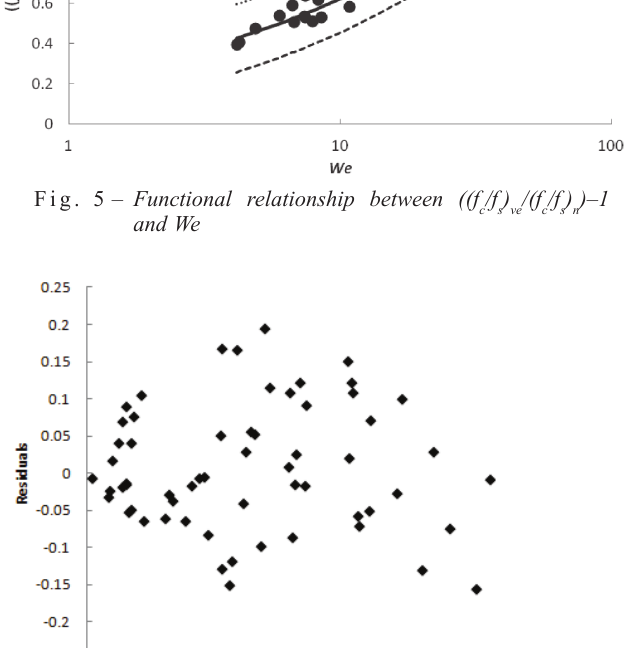
Fig. 6 – Residual plot